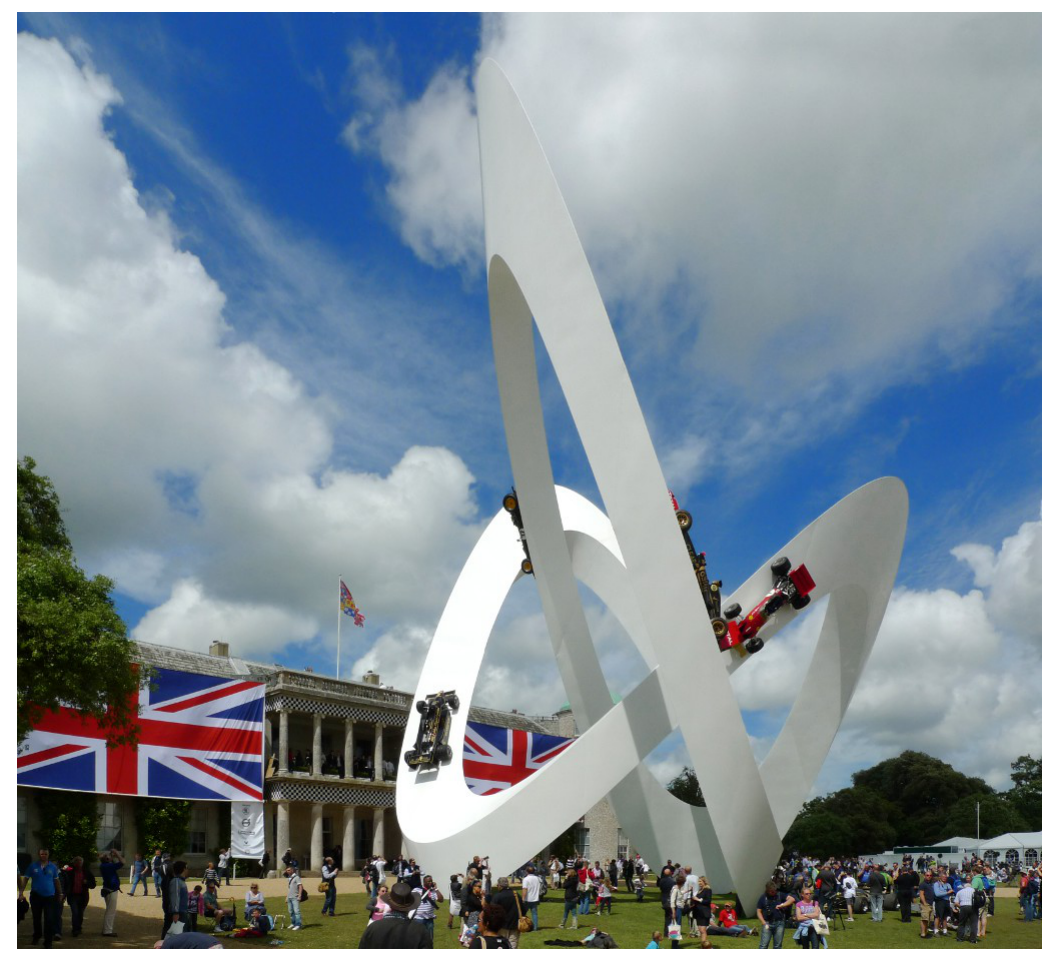
Figure 30. Completed structure. This is a photograph. Cars are classic Lotus Formula 1 cars from 1964 to the present